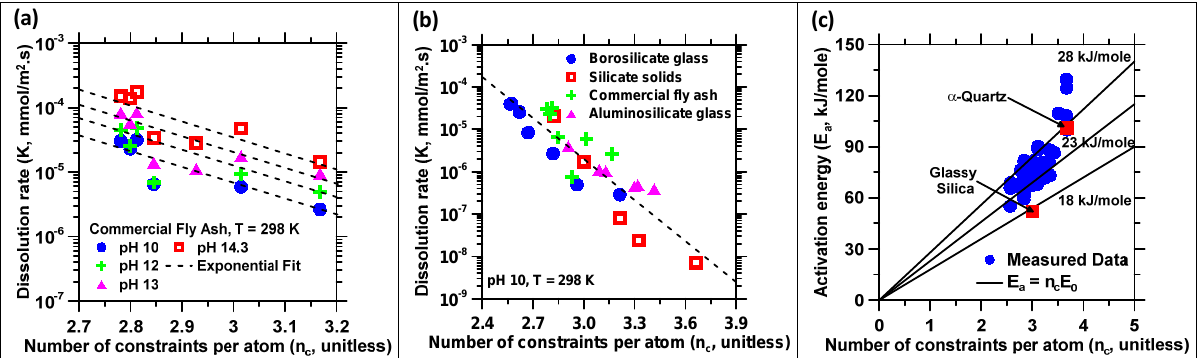
Figure 2. (a) The average dissolution rates of a range of Ca ‐ rich and Ca ‐ poor fly ashes as a function of the solution pH. The data is fitted by an exponential ( Arrhenius ‐ like ) function of the form K = K 0 exp(–n c E 0 /RT) [16]. (b) The dissolution rates of synthetic borosilicate glass [27], silicate solids (i.e., including glassy variants of albite, jadeite and nepheline, pristine α‐ quartz, and soda ‐ lime glass [60]), commercial fly ashes [17], and synthetic aluminosilicate glasses (i.e., with compositions similar to the average glass composition present in the commercial fly ashes) [28] as a function of the average number of atomic constraints (n c ) – for dissolution occurring at pH 10 at 298 K [28,30,43,61,62]. The slope of the linear regression in (a, b) reveals E 0 , i.e., the energy required to break or rupture a unit atomic constraint, to be on the order of 23 ± 5 kJ/mole. (c) The measured activation energy of dissolution of glassy silica and α‐ quartz as a function of the number of constraints per atom [35]. The data are compared with measured activation energies of sodium silicate (i.e., for self ‐ diffusion [60] and conduction [63] of Na), potassium silicate (i.e., for self ‐ diffusion [63] and conduction [64] of K) fused silica (i.e., for the diffusion of water [64]), and quartz (i.e., for the diffusion of water [65]). The dashed line shows the predicted activation energy (E a , kJ/mole) given by: E a = n c E 0 wherein E 0 takes values of: 18, 23, and 28 kJ/mole.